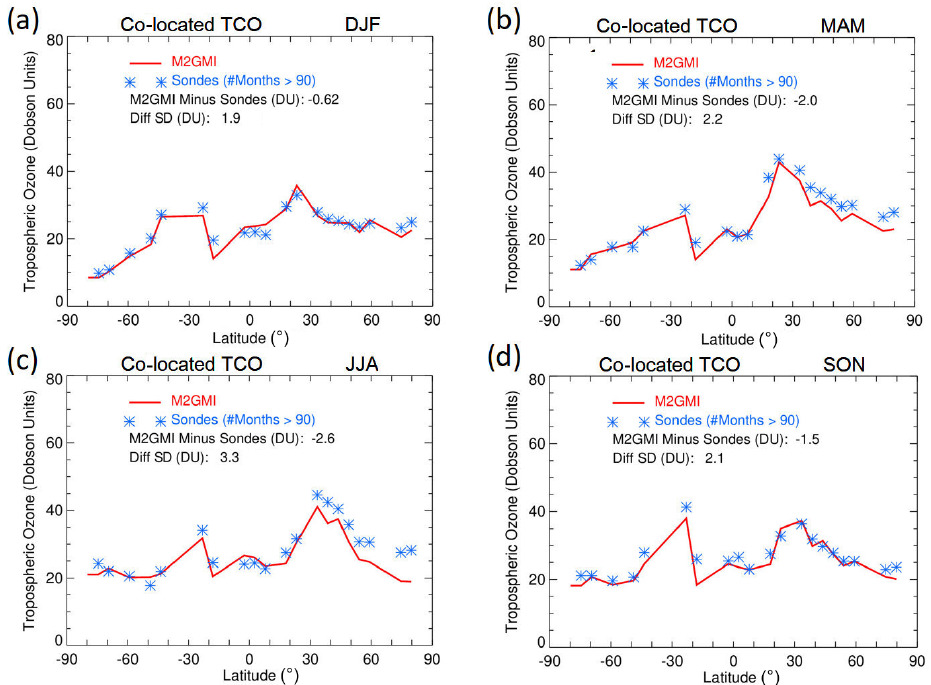
Figure 1. Comparisons between M2GMI simulated (red curves) and ozonesonde (blue asterisks) TCO averaged over 3-month seasons (indicated) for 2004–2016. The M2GMI TCO field is sampled daily at the sonde station locations. All TCO is in Dobson units (DU). The same daily tropopause is used for both M2GMI and sonde to derive TCO, and it is defined according to the WMO 2Kkm − 1 lapse- rate tropopause definition using NCEP temperatures. Included in each panel are mean offsets and standard deviations of TCO seasonal differences.